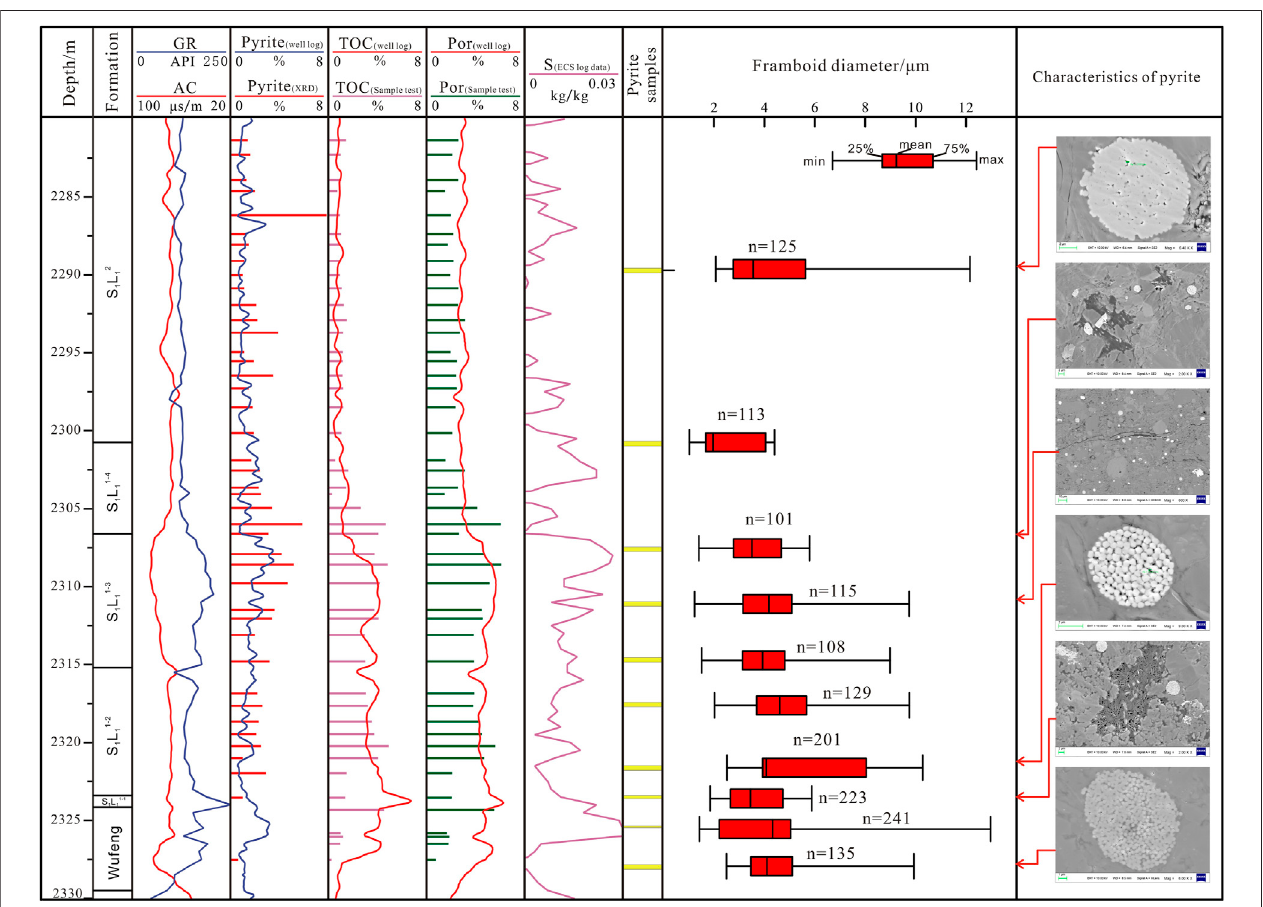
FIGURE 5 | Comprehensive comparison of geochemistry, reservoir physical properties and pyrite distribution characteristics of shale in the Longmaxi Formation.